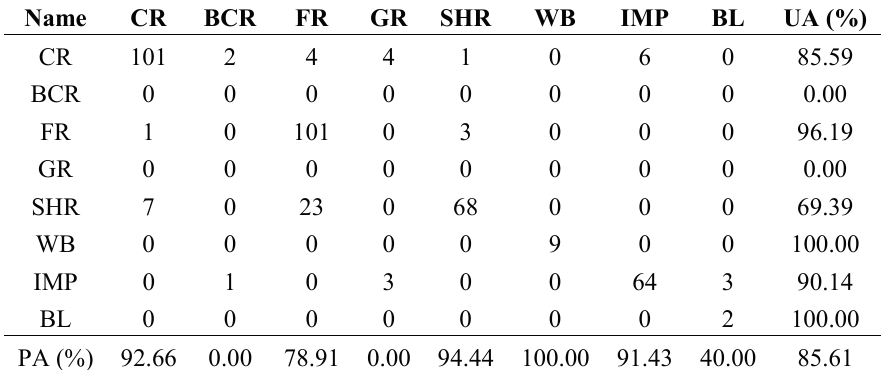
Table 6. Confusion matrix for a land cover map on day of year (DOY) 244 in process P9 (Overall Accuracy: 85.61%. CR = Croplands, BCR = Bare croplands, FR = Forests, GR = Grasslands, SHR = Shrublands, WB = Water bodies, IMP = Impervious, BL = Barren lands, UA = user accuracy, PA = producer accuracy).